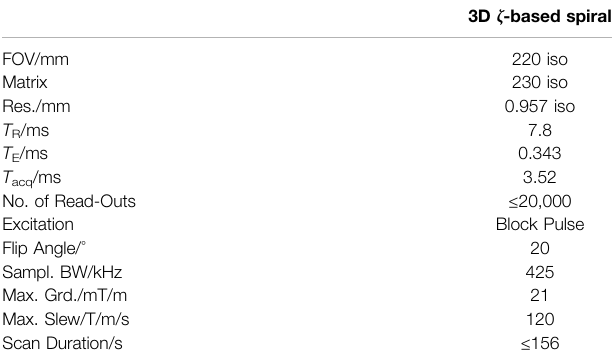
TABLE 1 | Scan parameters for all 3D ζ -based Spiral